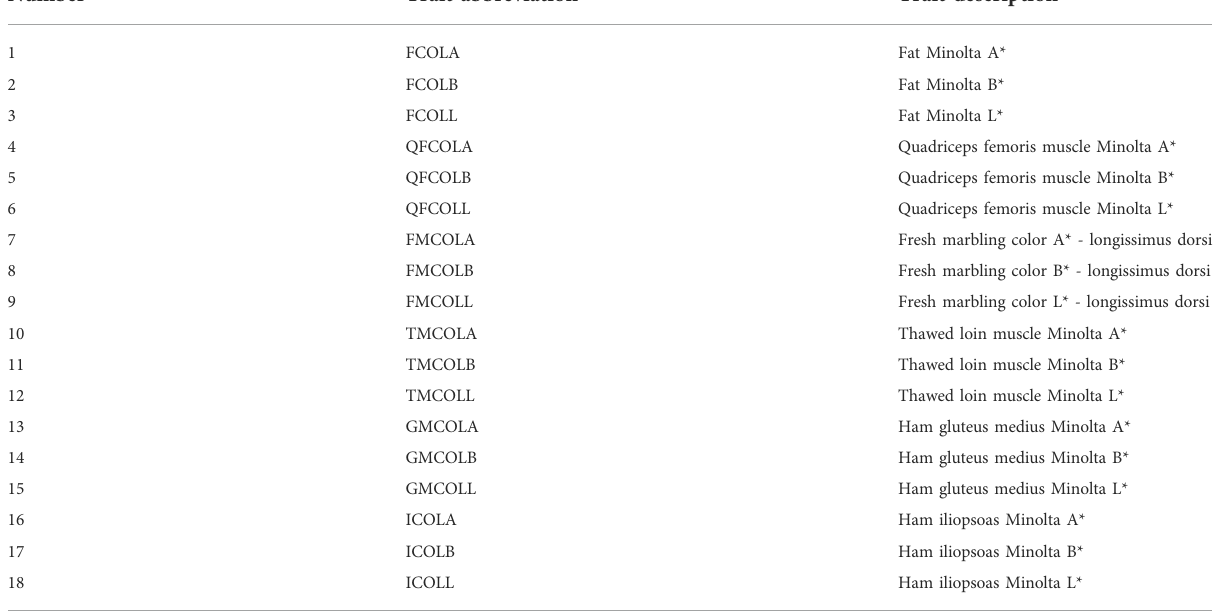
TABLE 1 List of pork color traits and their abbreviations.